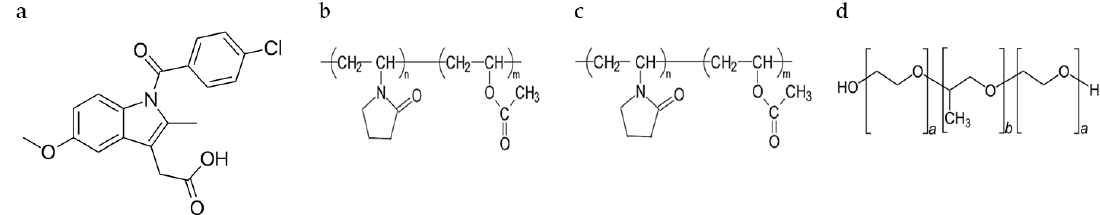
Figure 1. Chemical structures of ( a ) BCS class II model drug indomethacin [INM], ( b ) Poly(vinylpyrrolidone- co -vinyl acetate) [PVP VA64], ( c ) Plasdone S-630 [PL-S630] and ( d ) Poloxamer 407 [P407] used in this study.